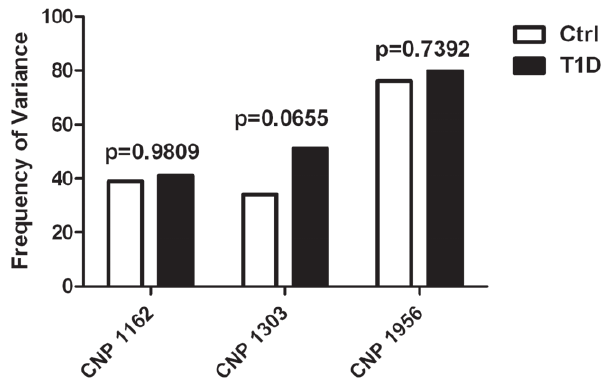
Figure 4. qPCR analysis of 3 T1D enriched CNPs in independent cohorts. Frequency of variance is shown for an independent Ctrl cohort (n=73) and an independent T1D cohort (n=73) at 3 CNP locations. Copy number was determined by DD Ct calculations from qPCR data. p -values detemined by chi-square analysis.